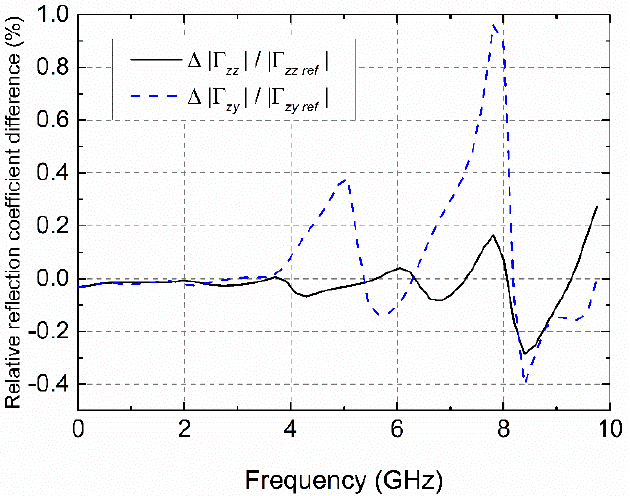
Figure 10. Relative difference obtained in the reflection coefficient magnitude for the TLM results and the FDTD results used as reference. The difference of TLM and FDTD results has been normal- ized to the FDTD reference results.